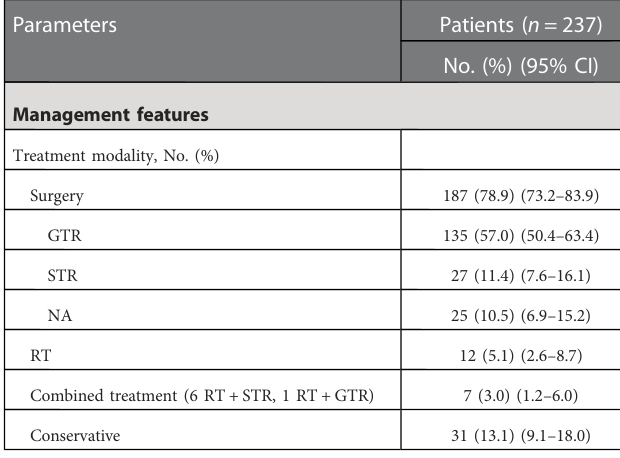
Table S2 ). Notably, dual attachment (10.5%) and calci fi cation (2.5%) can also be seen in CT imaging and MRI for supratentorial hemangioblastoma ( Supplementary Table 2 ). The total follow-up of these cases ranged from 0 to 276 months ( Supplementary Table S3 ).